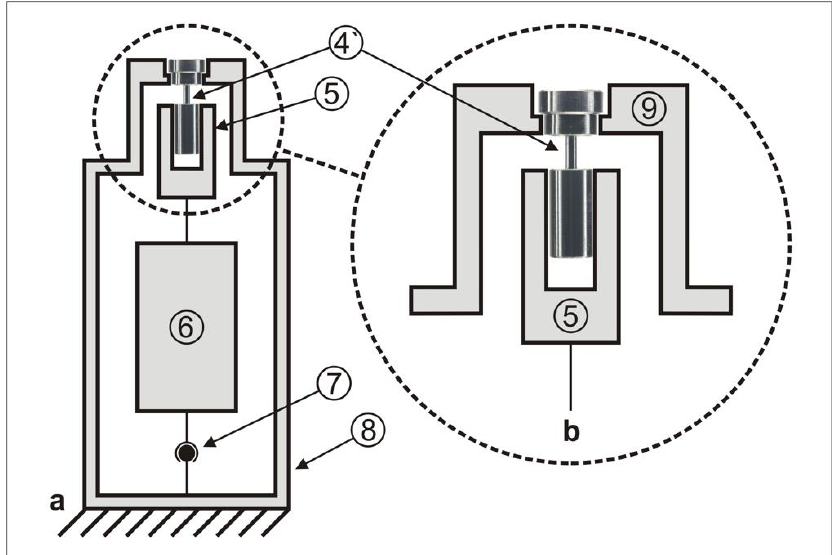
Figure 3. Measurement arrangement ( a ) with enlargement ( b ) (#4’: “simulated implant–abutment connection”; #5: collet chuck for thread sleeve; #6: combined force and torque sensor; #7: cardan joint; #8: housing of measurement station; #9: fixture of abutment analog).